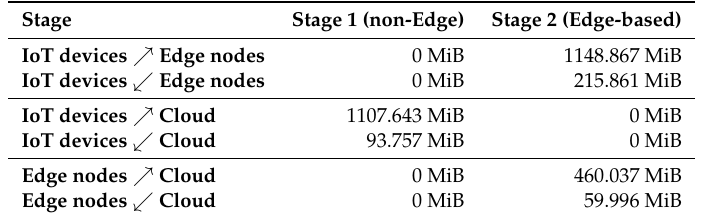
Figure 8. Comparison of the amount of data transferred in the two tests (downlink). Table 1. Data transmitted between the different IoT, Edge and Cloud components in the two four-week